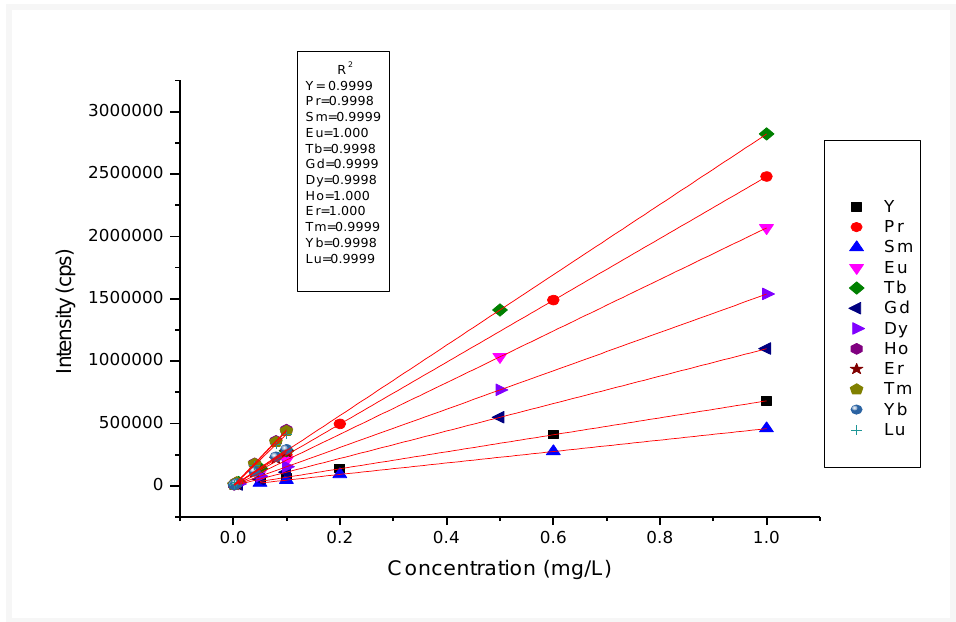
Figure 1. Regression plots obtained for HREEs at various concentration ranges.